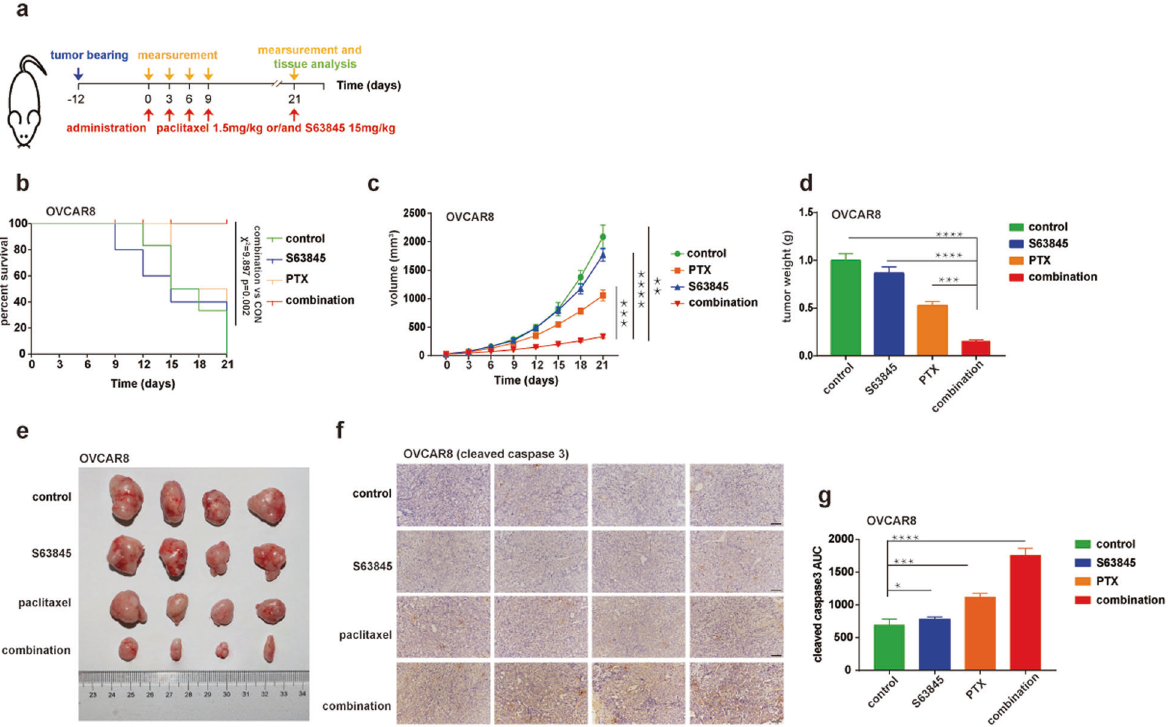
Fig. 7 The paclitaxel/S63845 combination inhibits the growth of xenografts bearing BAK/MCL1 complexes. a Diagram of this assay. b Kaplan – Meier survival curve of OVCAR8 inoculated mice. Each group was treated with or without paclitaxel (1.5 mg/kg) and/or S63845 (15 mg/kg) as indicated in panel ( a ). COX proportional hazards model for paclitaxel + S63845 vs. control was χ 2 = 9.897 ( p = 0.002), while no signi fi cance was observed for paclitaxel or S63845 vs. control ( n = 10). c , d Tumor volume ( c ) and weight ( d ) of each group ( n ≥ 4 mice in each group at the start of treatment, mean ± S.E.M.) observed in OVCAR8 tumor-bearing mice after the start of treatment with vehicle (control), S63845, paclitaxel, and paclitaxel + S63845. e Tumors from the control group, S63845 group, paclitaxel group, and combination group were obtained for comparison from OVCAR8 tumor-bearing mice at day 21. f , g Cleaved-caspase 3 by IHC using tumor tissue from OVCAR8 tumor- bearing mice at day 21 ( f ) and the intensity pro fi ling of DAB stained image were calculated using ImageJ program ( g ). All images are captured at 20× magni fi cation. ( n = 4, mean ± S.D.) Scale bar in panel f 200 μ m. Statistical signi fi cance in panels c , d , and g was determined by a two- sided unpaired Student ’ s t test. * p < 0.05; ** p < 0.01; *** p < 0.001; **** p <